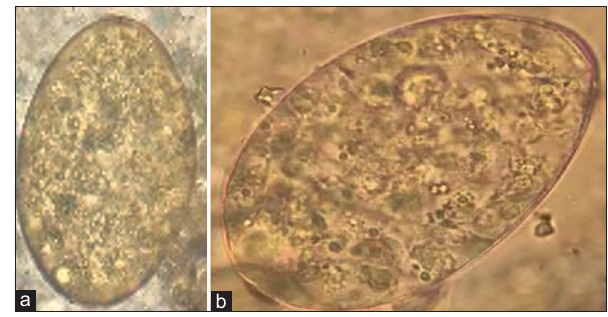
Figure-1: Fasciola egg present in fecal of cattle under microscopy 40× (a) Fasciola spp. egg (b) Paramphistomum spp.